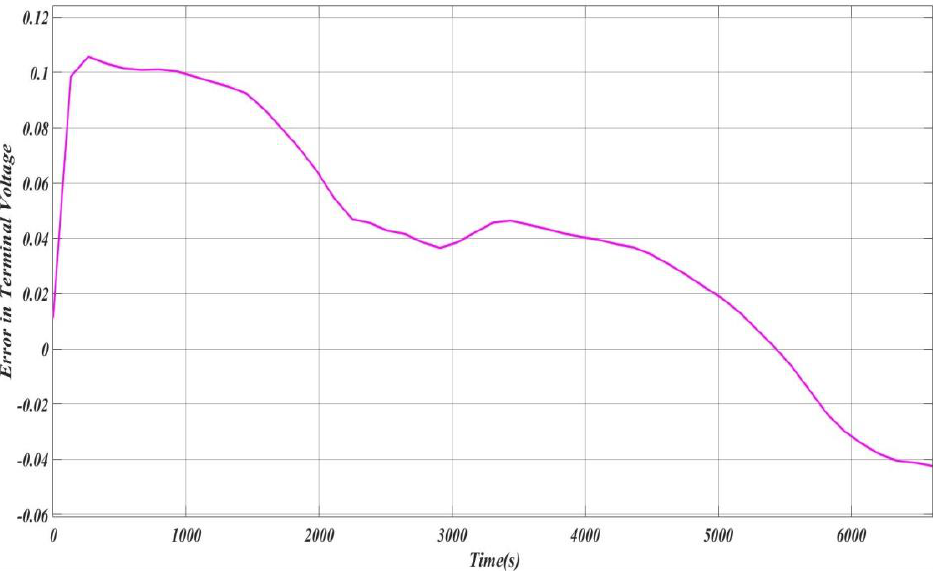
Figure 12. Error in voltages for reference discharge.